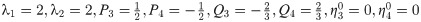
Time evolution of mixed solution |u| of the two dimensional nonlocal NLS equation.Time evolution of mixed solution |u| of the two dimensional nonlocal NLS eq (2) in (x, y) plane with parameters λ1=2,λ2=2,P3=12,P4=−12,Q3=−23,Q4=23,η30=0,η40=0.